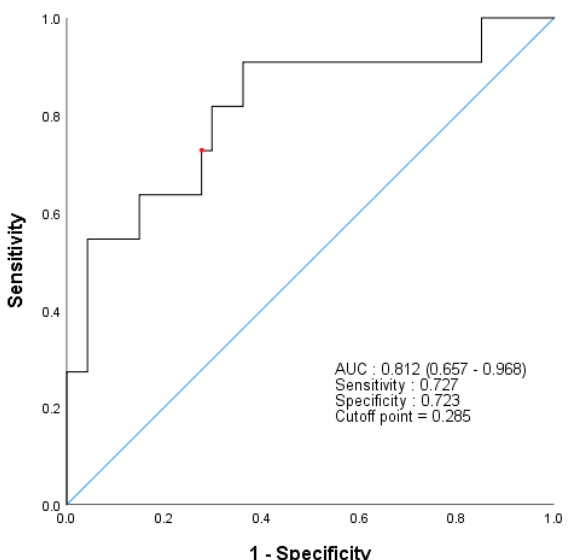
Figure 1. ROC curve of the GPx3 change in recurrence prediction. The AUC was 0.812 (95% CI, 0.657–0.986), and the cutoff point (0.285 μ g/mL, red dot) was identified on the basis of the highest Youden index, with a sensitivity of 72.7% and specificity of 72.3%. Abbreviations: ROC, receiver operating characteristic; GPx3, glutathione peroxidase 3; AUC, area under the curve; CI, confidence interval.